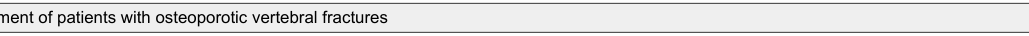
Table 2: Assessment and treatment of patients with osteoporotic vertebral fractures Patients with acute back pain and a risk profile (age, known osteoporosis; red flags) should undergo a radiological investigation (standing X-ray of the painful spine section). Patients with a documented fracture and severe / ongoing pain show a high risk for progressive collapse of the vertebral body and therefore should have a follow up X-ray check one to two weeks after the index check. If the FU X-ray shows progressive height loss (>30%) patients should be considered for a vertebroplasty or stentoplasty procedure if there is a relevant deformity. If patients are immobilised and / or need a hospital stay due the painful fracture, surgery should be considered. This serves to shorten the hospital stay and is therefore cost effective [17]. Patients with subacute fractures and persistent pain may present with nonunion of the fracture (so called Kummel disease). The diagnosis is best performed by a CT or MRI scan. If a non-union is present, cement reinforcement can provide stability and control pain. High risk patients with multiple osteoporotic fractures within a short time period should be treated early with (repetitive) cement reinforcement, if necessary also with a prophylactic purpose [9, 18]. Subacute fractures (4–6 weeks) with severe collapse can be reduced by closed means or stentoplasty if needed. Vertebral fractures due to metastatic lesions or myeloma can be treated with cement reinforcement if the posterior elements remain intact and no neurological involvement is present [19].